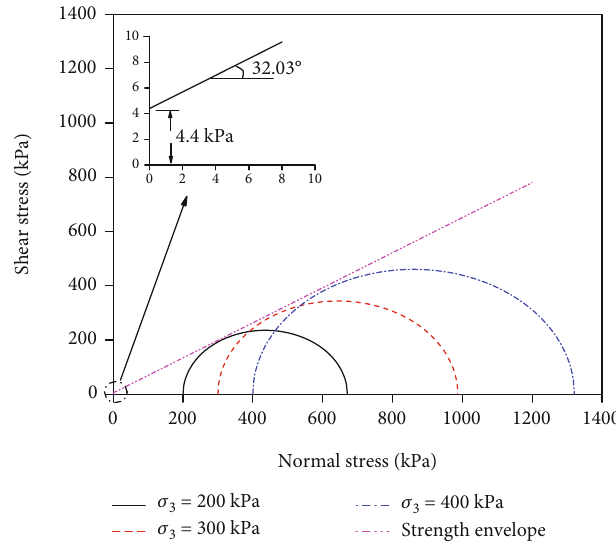
Figure 11: Numerical results under fi nal parameters of tailing